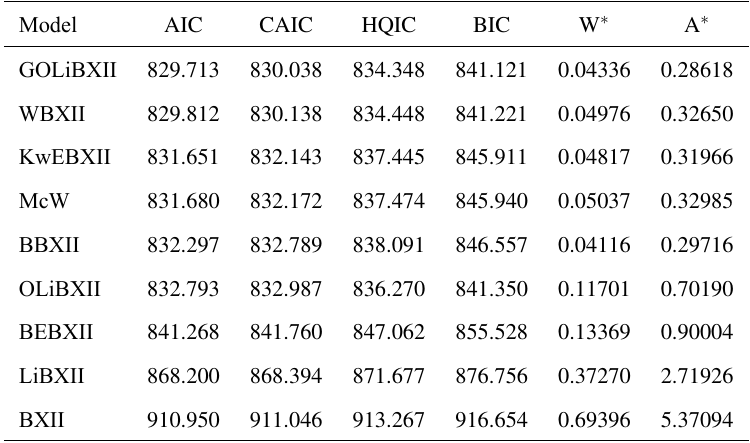
Goodness-of-fit statistics for cancer